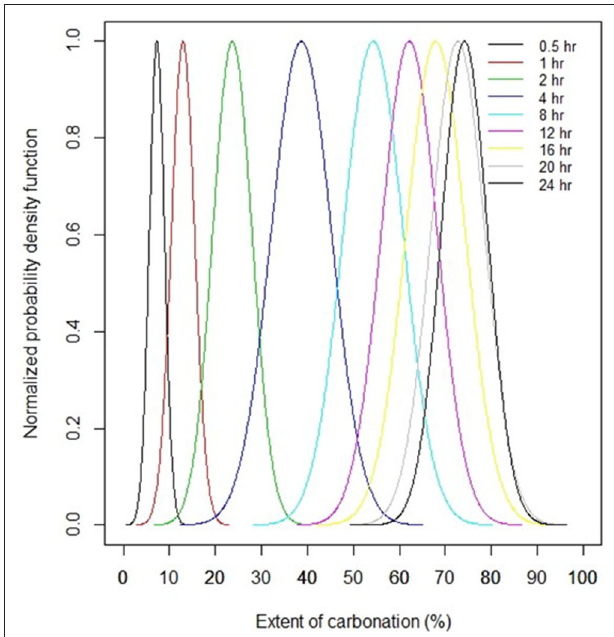
FIGURE 10 | Statistical analysis of the variation of the extent of carbonation of Ni-slags as a function of reaction time (distributions move from left to right with increasing reaction